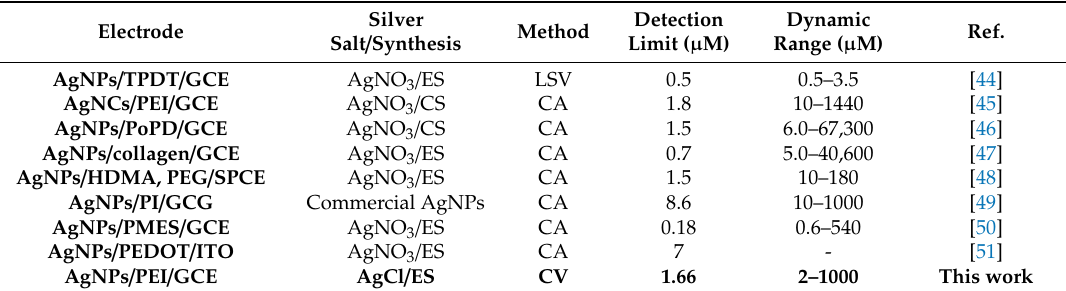
Table 1. Performance comparison of developed AgNPs / PEI and AgNPs / organic polymer electrodes for the electrochemical determination of H 2 O 2 .